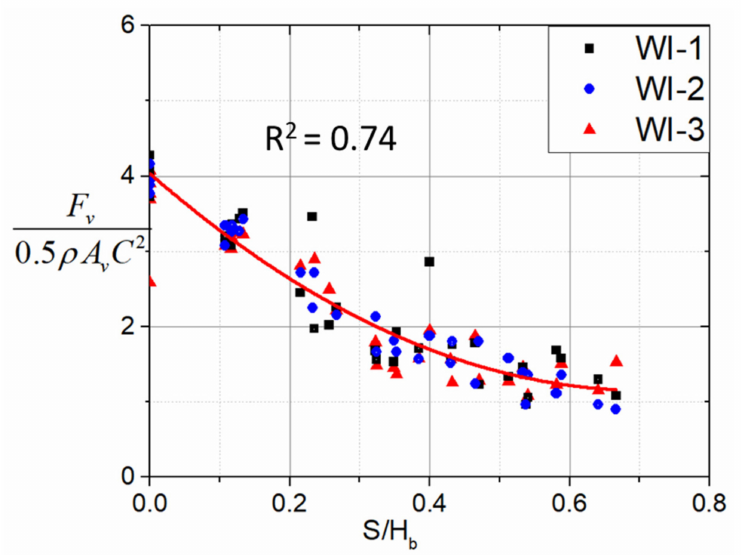
Figure 23. Variation of vertical force coefficients at three wave impact scenarios for different S/H b